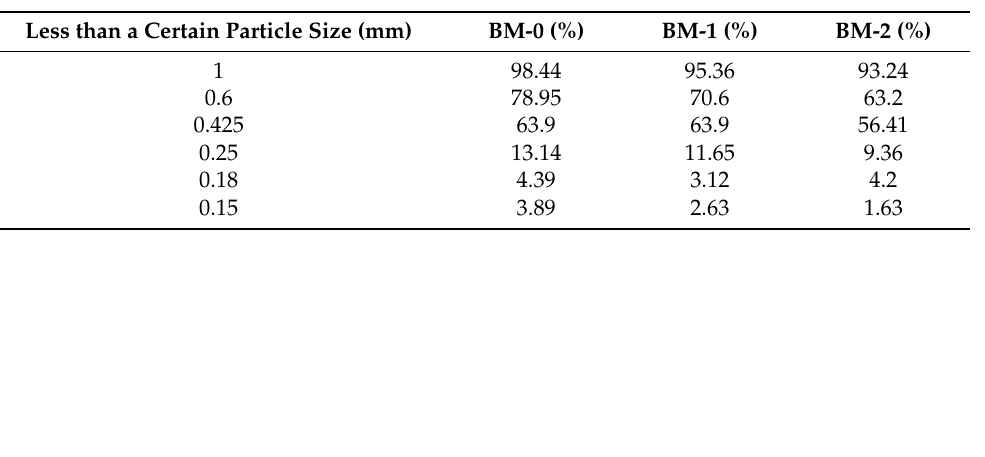
Figure 2. Charts of the XRD and main ingredients.( a ) Composition of grinded sand; ( b ) Composition of [3A-MS].